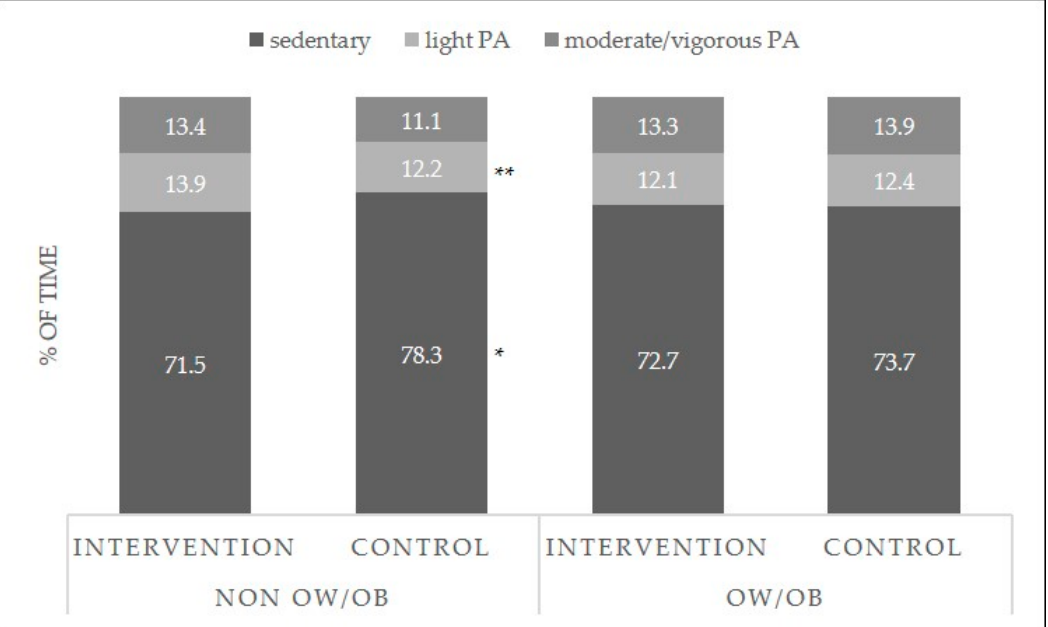
Figure 2. Percent time spent in sedentary or light and moderate/vigorous activities by intervention and control participants grouped by BMI category. ** p = 0.012; * p = 0.022 versus intervention group (Mann–Whitney test); PA: physical activity; OW: overweight; OB: obese.